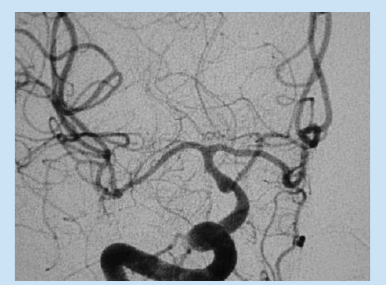
Fig.1a.36-year-old woman with last trimester pre-eclampsia with severe postpartum hyper- tension and intracerebral haemorrhage 11 days after delivery.Note the generalised spas- tic appearence of the central cerebral arteries at arteriography.